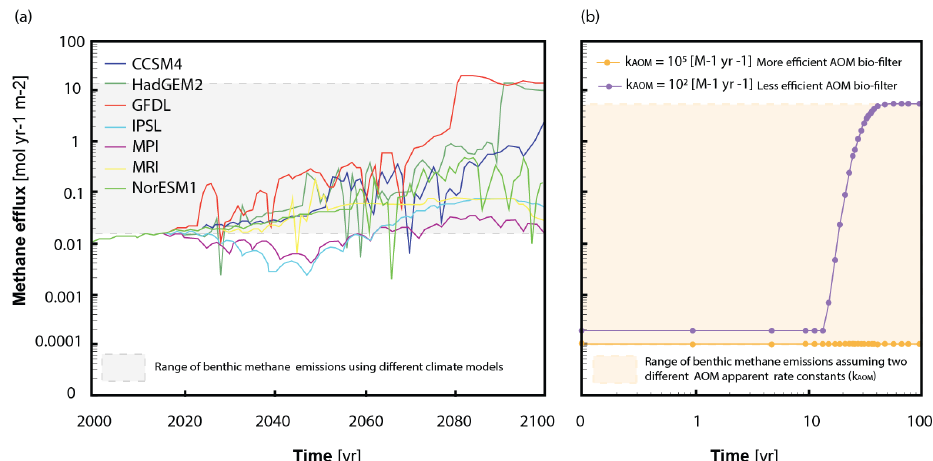
Figure 2. Range of benthic methane emissions predicted using ( a ) different climate models (colour coded) under the IPCC climate scenario RCP 2.6 at 420 m water depth west of Svalbard, and ( b ) a reaction-transport model that simulates a transient scenario in which a methane advective flow of 10 cm yr − 1 is imposed at the bottom of the sediment column at 0 years, and where a biomass-implicit bimolecular AOM rate is used with two different kinetic constants ( k AOM , see Section 3.2). During the first 12 years of simulation (panel b ), the effect of the imposed methane advective flow on methane efflux is null because time is required for methane to be transported up to the sediment-water interface. The initial difference in methane efflux for the two AOM scenarios (purple and orange lines prior to 12 yr) is caused by the distinct values of k AOM used to compute the corresponding AOM rates. After 12 years, and only for the less efficient AOM scenario ( k AOM = 10 2 M − 1 yr − 1 , purple line), a fraction of the additional advected methane escapes the bio-filter, increasing the methane efflux until a steady state is reached after 70 years. With highly efficient AOM ( k AOM = 10 5 M − 1 yr − 1 , orange line) all the methane is consumed within the sediment and no methane efflux is estimated regardless of the boundary condition applied. CCSM4: The Community Climate System